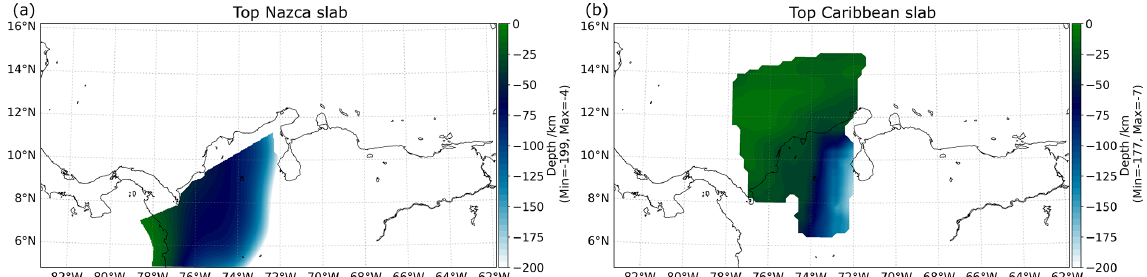
Figure 5. Depth to the top of the slabs tested in the lithospheric-scale gravity models. (a) Nazca geometry from the Slab2 dataset (Hayes et al., 2018). Note that this geometry does not differentiate the Nazca (Coiba) and the Caribbean components in the slab. (b) Caribbean slab as published by Mora et al.